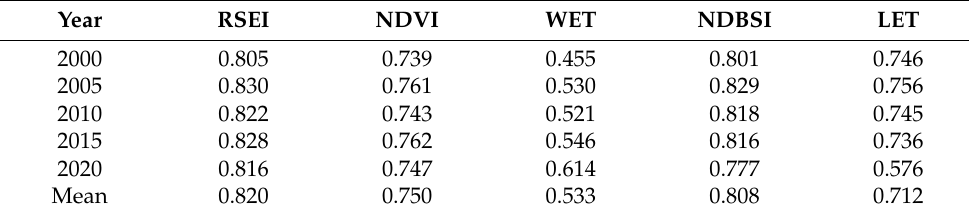
Figure 3. Pearson correlation coefficient of ecological factors from 2000 to 2020. Table 3. Statistical chart of average correlation degree based on correlation